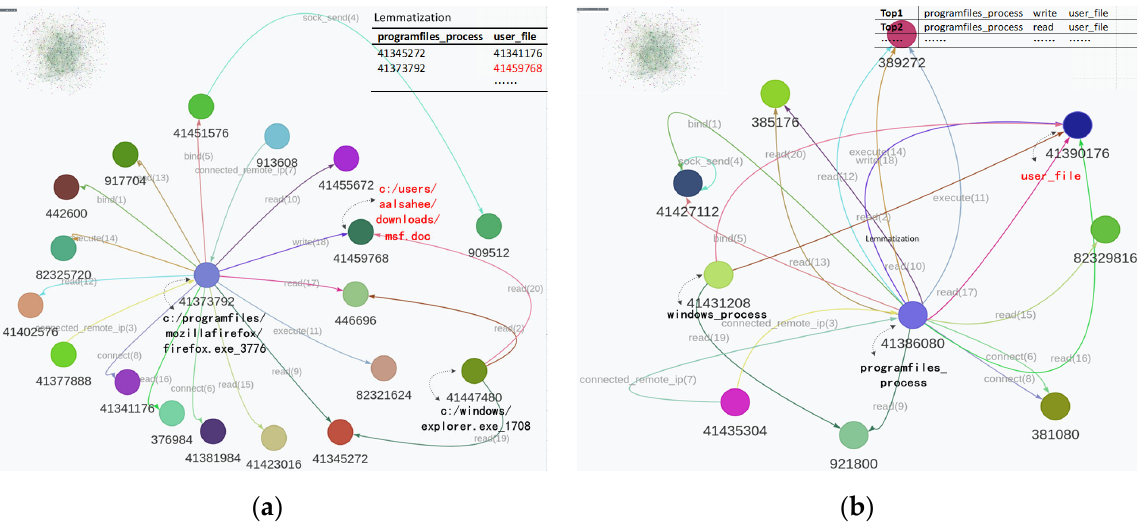
Figure 9. Case study based on evolving graph. This is an example of malicious event prediction based on evolving graph. Due to the long names of some entities, a temporary ID (which does not represent any statistical significance) was randomly generated for each node, such as a malicious file (File ID: 41459768; File Name: c:/users/aalsahee/downloads/msf.doc). ( a ) The original evolving graph. ( b ) The evolving graph after